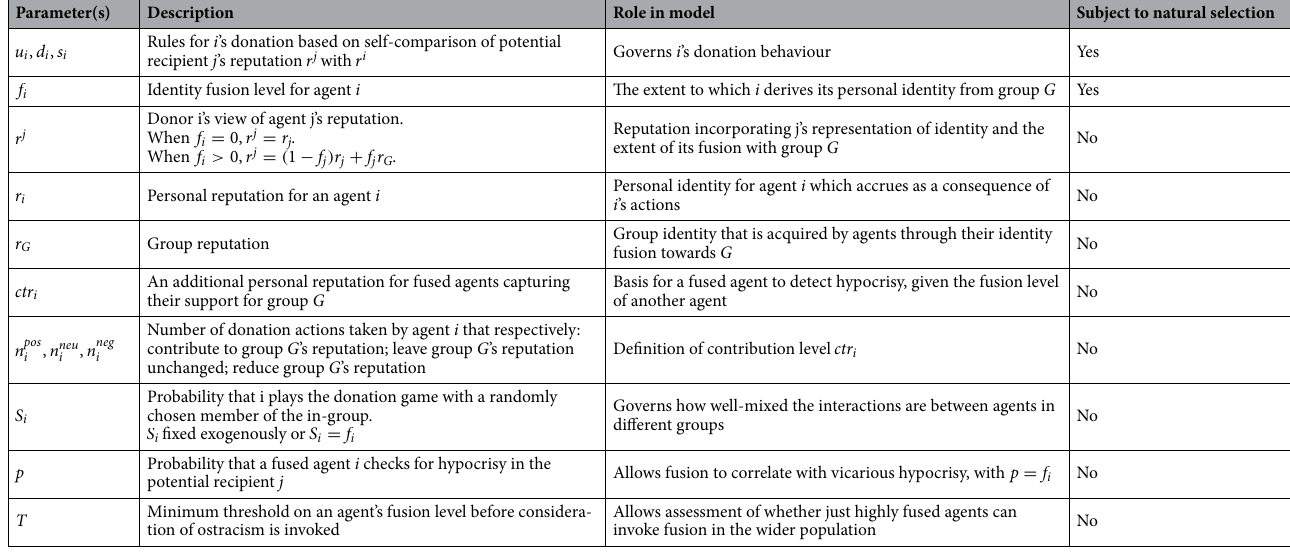
Table 1. Key parameters of the model for an agent i